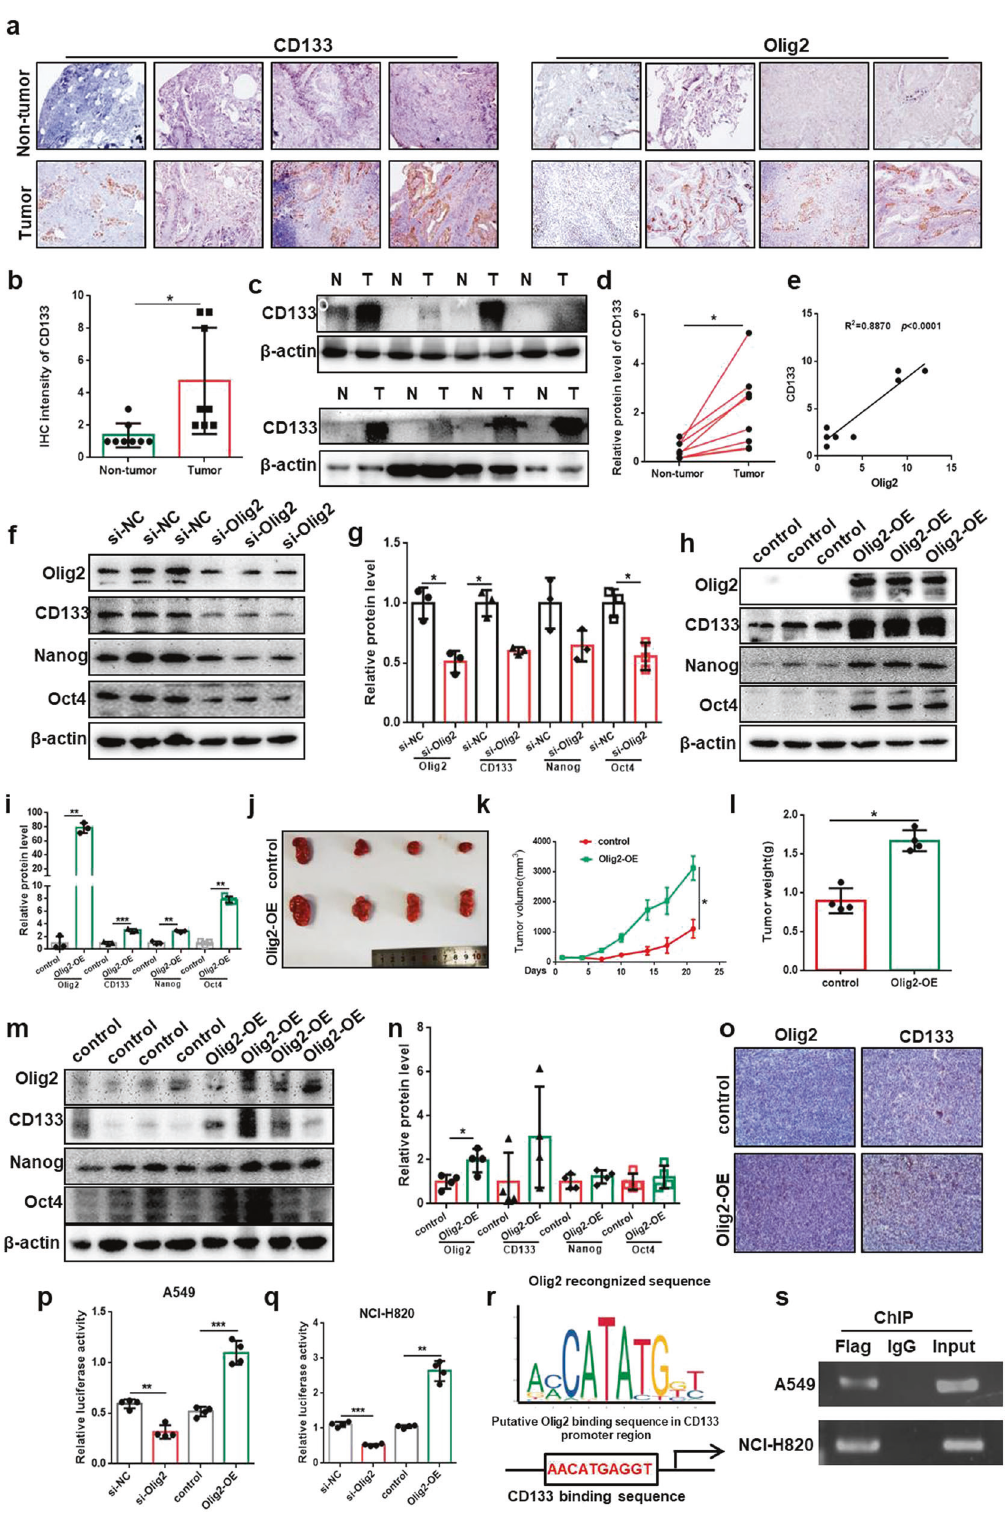
different dose of ACT001 groups. The results showed that there was no signi fi cant difference in body weight of pregnant rats between ACT001 groups and vehicle control group (Fig. S1c), indicating that ACT001 had no impact on weight gain of pregnant rats. Simultaneously, there was no signi fi cant difference in